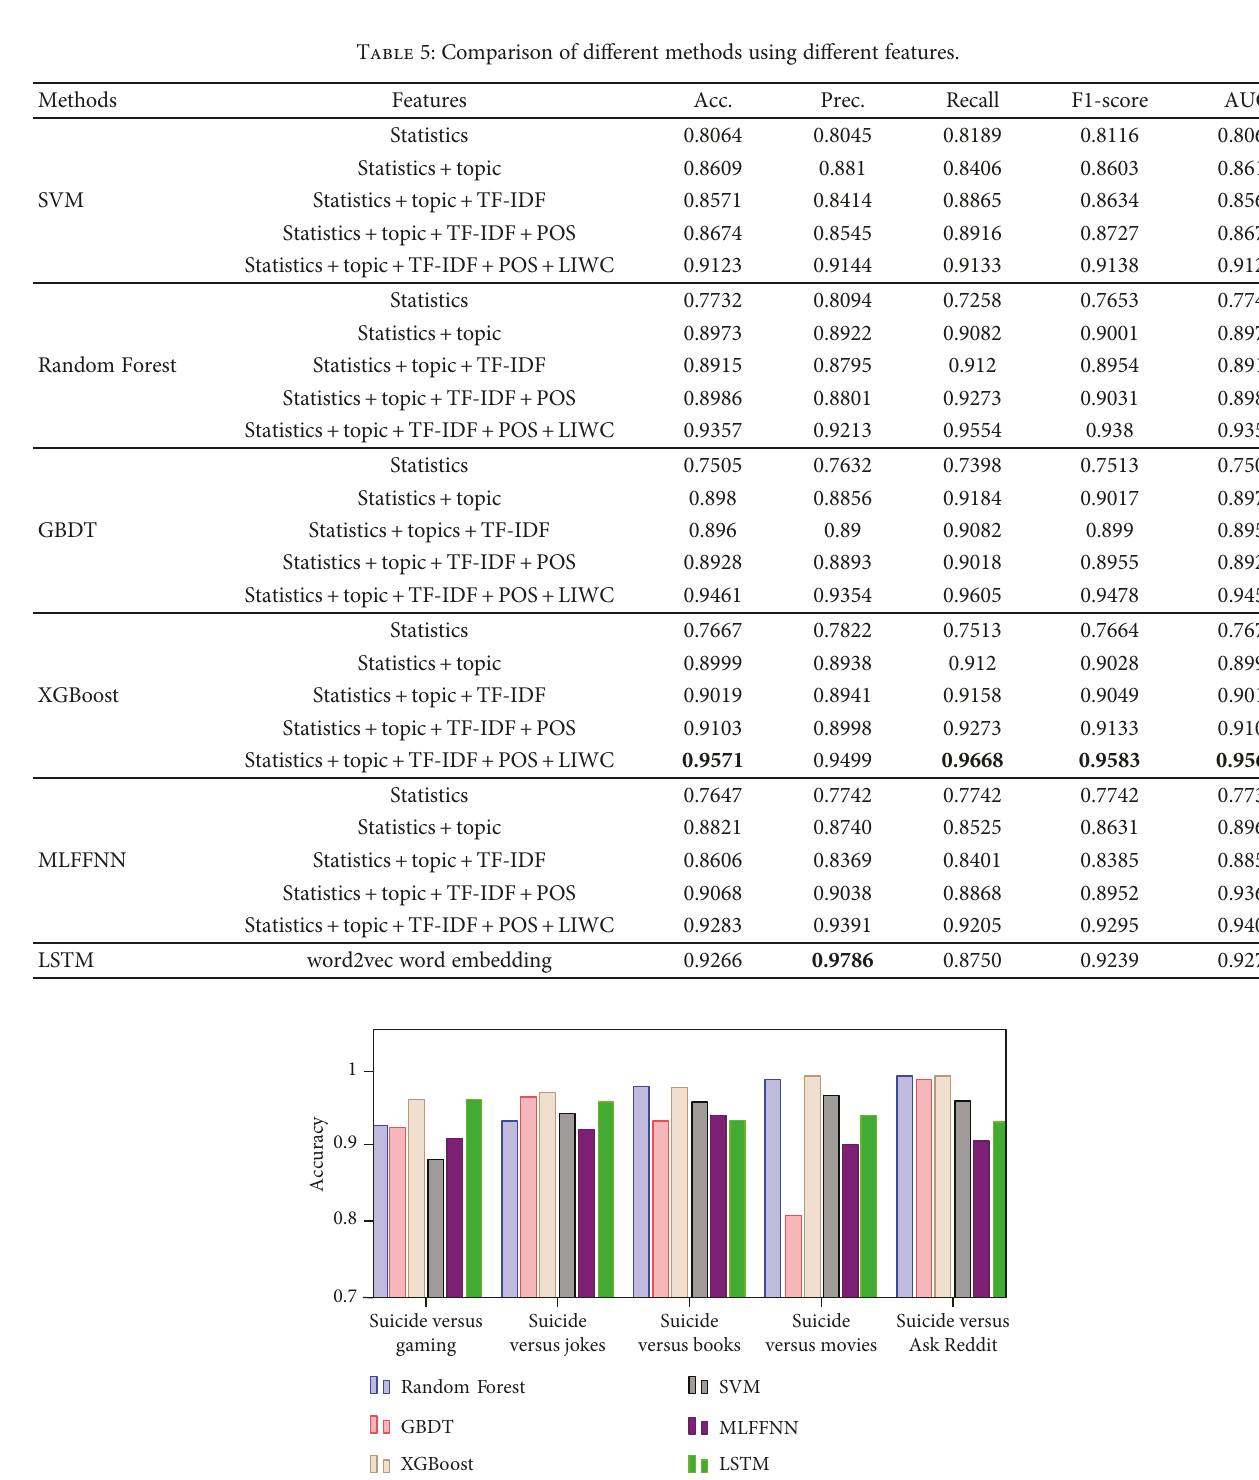
Figure 4: Classi fi cation for suicidal ideation of SuicideWatch versus other six subreddits.